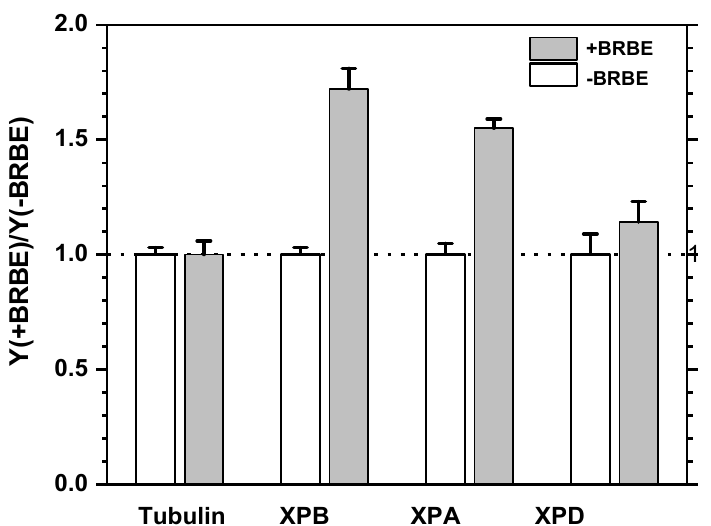
0.0 Figure 9. Effect of BRBE treatment of HeLa cells on the expression of selected NER proteins. Compared with the untreated HeLa cells, the XPA and XPB protein expressions are remarkably up regulated in the BRBE treated group relative to the untreated HeLa cells by 72 ± 9%, while the XPB protein levels were 55 ± 4% higher. By contrast, the levels of XPD were higher in BRBE-treated cells by only 14 ± 9% which is close to the reproducibility of the ( − )BRBE control experiments. Overall, these results suggest that the significant upregulation of the NER factors XPA and XPB is correlated with the NER response to BRBE treatment, while enhancement of XPD expression is close to the baseline (Figure 7). These findings clearly point to an impact of BRBE on the expressions of selected NER proteins that suggest further in-depth studies of these phenomena that were beyond the scope of this study. It should also be noted that BRBE protects cellular proteins against glycation